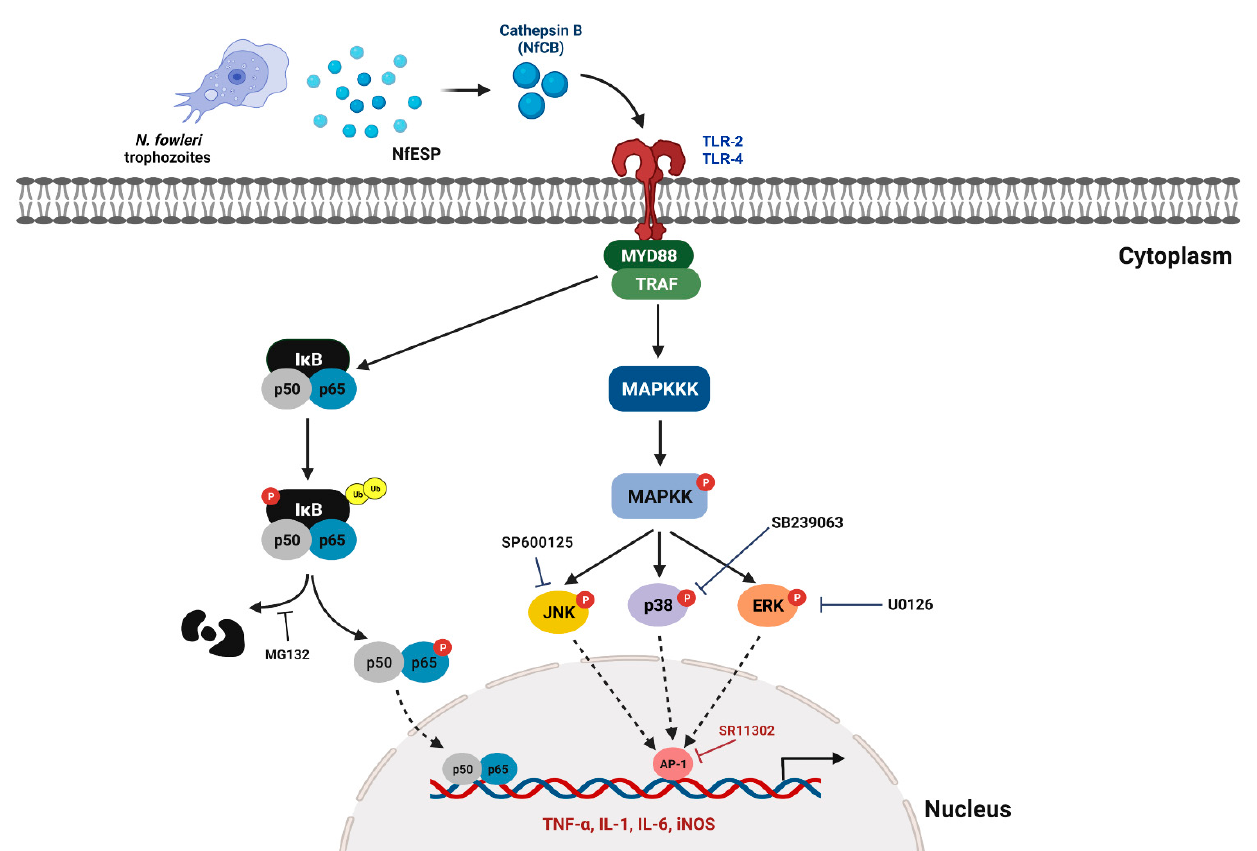
Figure 8. Summarized scheme of signaling pathways involved in rNfCB-induced pro-inflammatory immune responses of BV-2 microglial cells. NfCB induces a pro-inflammatory immune response of BV-2 microglial cells, which is initiated via MyD88-dependent TLR-2/TLR-4 pathway and mediated by NF- κ B- and AP-1-dependent MAPK signaling pathways. The image was created with